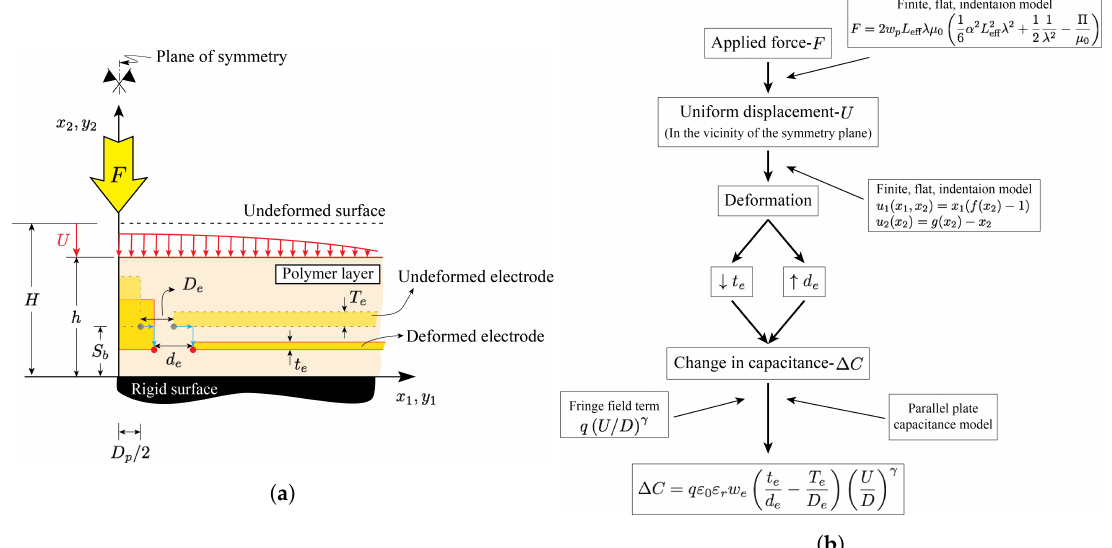
Figure 4. ( a ) A schematic of the half symmetric cross section of the tactile sensor designed and fabricated in [48] and modeled in this study; ( b ) A flowchart showing the process used in this study to model the relationship between the change-in-capacitance and applied